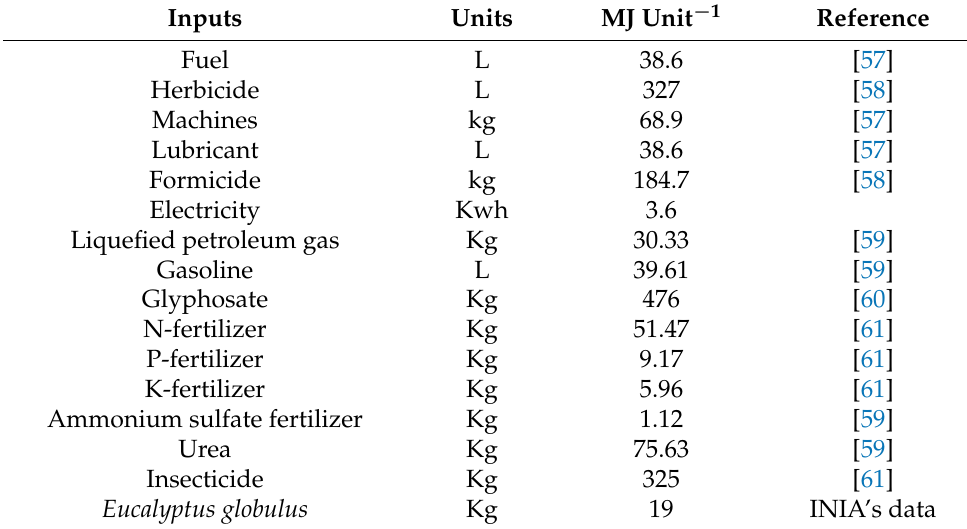
Table 8. Energy conversion factors used for EROI estimation.